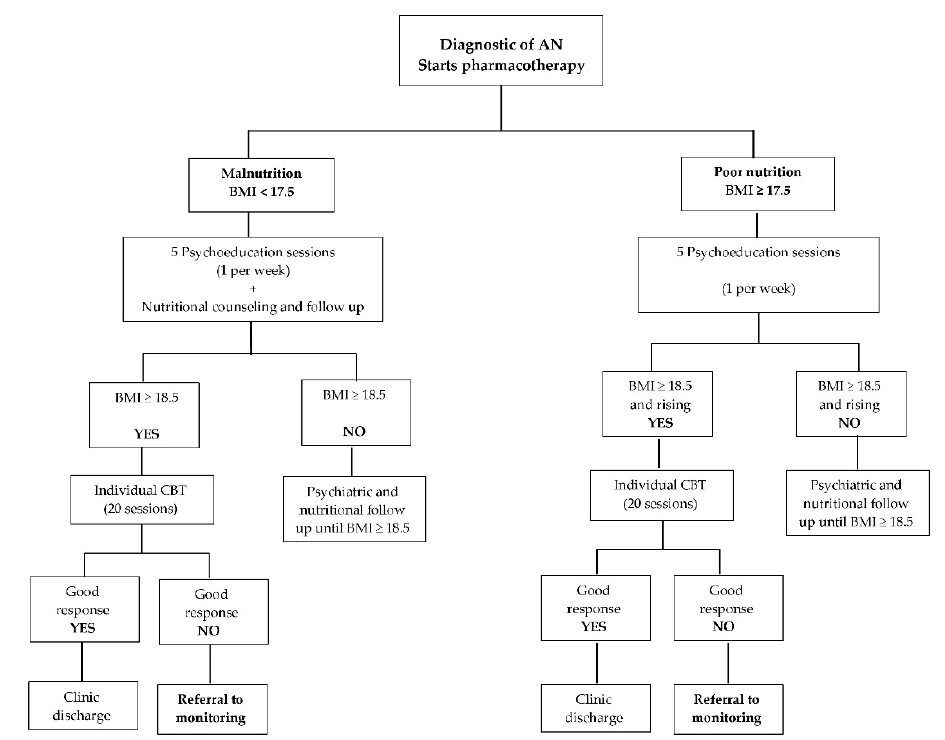
Figure 1. Algorithm of treatment used at the CED. Time elapsed from admission to the clinic to referral to monitoring, varies depending on each patient’s individual response, number of relapses, and adherence to treatment.